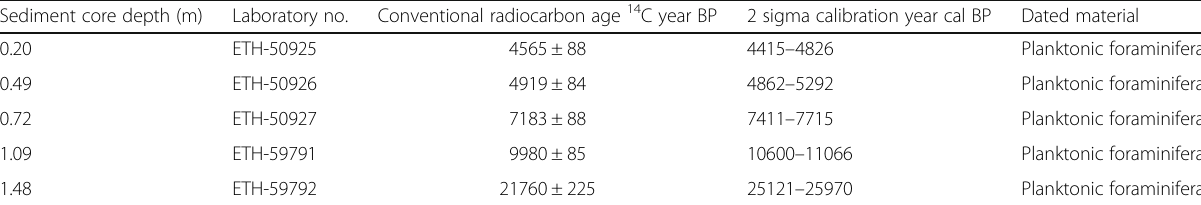
Table 2 Radiocarbon ages obtained for foraminiferas ( Globigerina inflata ). Calibration was performed with the “ calibrate ” function of the clam code (Blaauw 2010) from the open-source statistical software “ R ” using the marine calibration curve Marine13.14C (Reimer et al. 2013). A reservoir age of 98 years was used Sediment core depth (m)